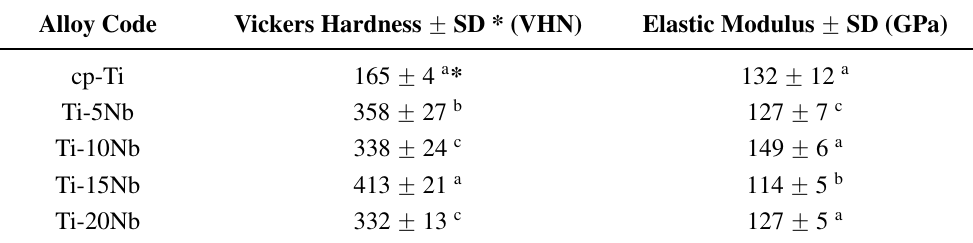
Table 2. Vickers hardness and elastic modulus values of Ti-xNb alloys and cp-Ti ( n =